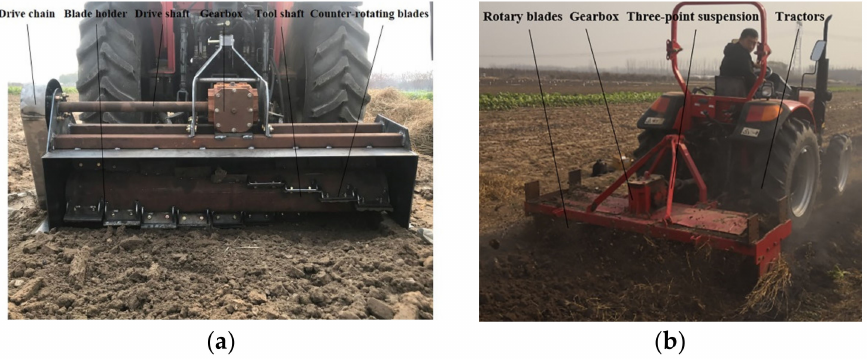
Figure 14. Field trial. ( a ) The counter-rotating excavation device; ( b ) the positive-rotating excavation